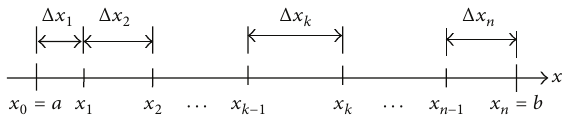
Figure 2: Subdivision of the closed area into variable